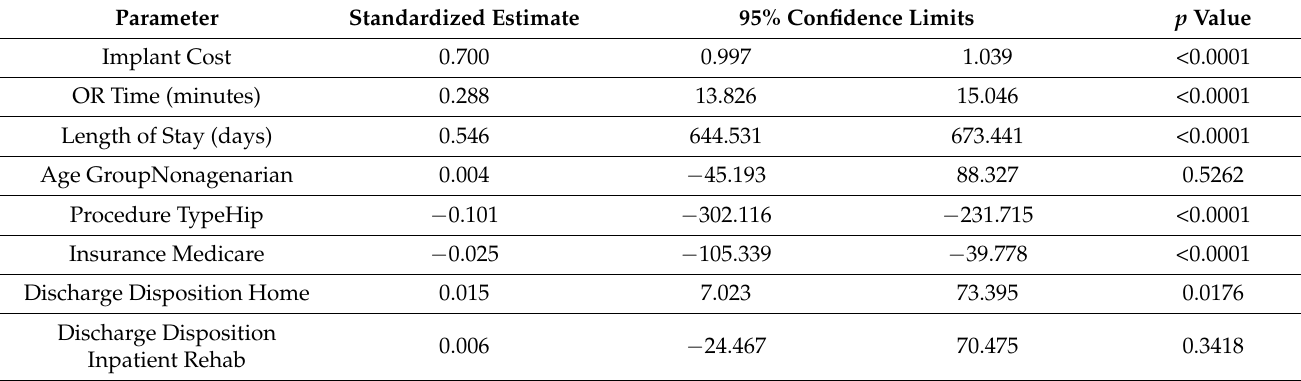
Table 5. Multivariate linear regression for total in-hospital cost. Adjusted R-square = 0.9713. OR = operating